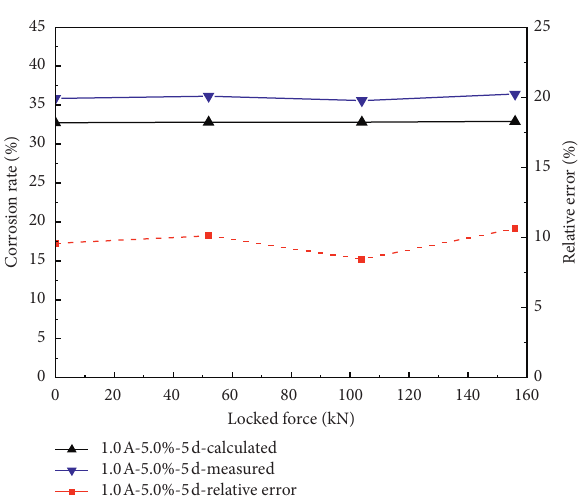
Figure 10: Corrosion rate and RE of anchor samples for different locked